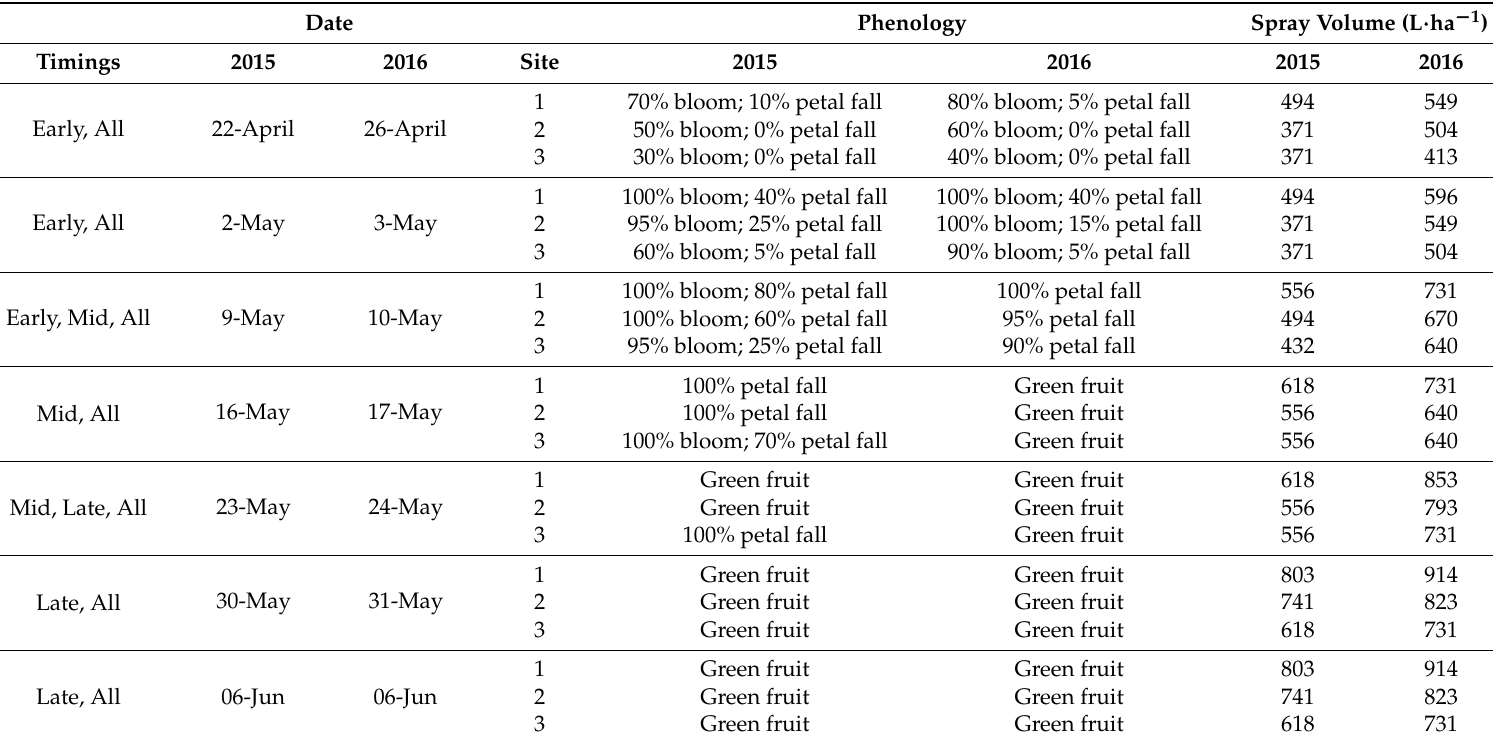
Table 1. Dates, plant phenological stages and foliar Ca application spray volumes made to ‘Draper’ highbush blueberry across three farm sites in the Fraser Valley, British Columbia, Canada in 2015 and